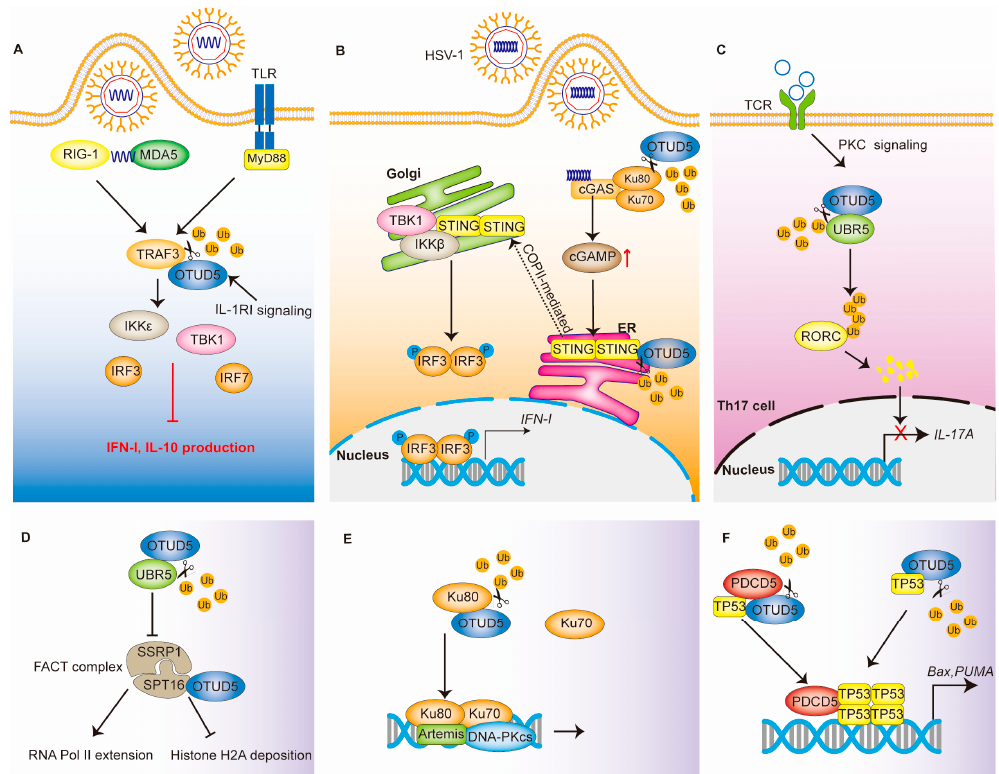
Figure 2. The regulatory network of OTUD5 in immune response and DNA damage repair. ( A